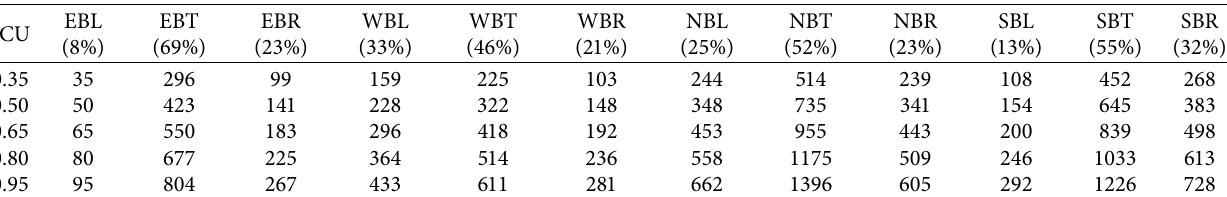
Figure 6: Snapshot of test intersection (Source: Bing Table 3: Tested volumes along the intersection.